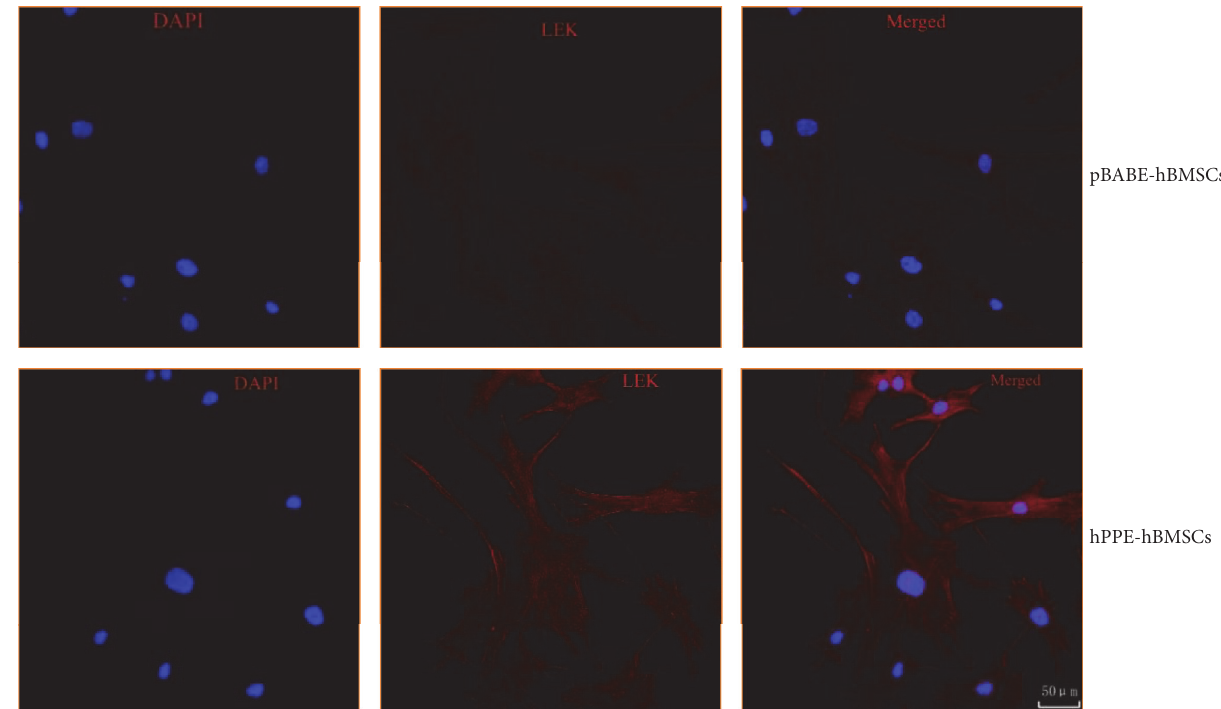
Figure 2: The different expression levels of Leu-enkephalin (L-EK) protein were compared between the pBABE-hBMSC group and the hPPE- hBMSC group by immunofluorescence. pBABE, a retroviral vector; hPPE, human proenkephalin; hBMSCs, human bone marrow stem cells; pBABE-hBMSCs, the pBABE-hBMSC group; hPPE-hBMSCs, the hPPE-hBMSC group. Blue fluorescence marks the nucleus of the hBMSCs by 4 󸀠 6-diamidino-2-phenylindole (DAPI). Red fluorescence marks L-EK protein. Double-labeled cells, with a blue fluorescent nucleus and a red cytoplasm, represented hBMSCs that expressed the L-EK. There were on differences in nuclear staining between the groups. Little L-EK expression was observed in the pBABE-hBMSC group, whereas greater expression was detected in the hPPE-hBMSC group. All images were obtained with a laser scanning confocal microscope (Leica). Scale bars = 50 𝜇 m, 𝑛 = 6